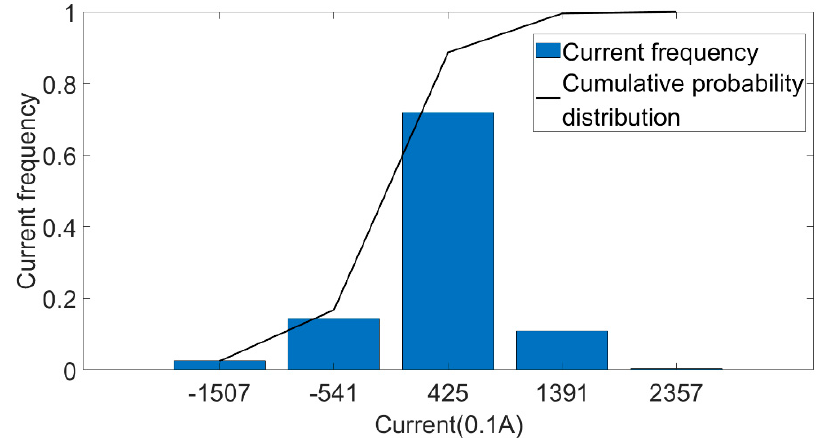
Figure 22. Current frequency distribution.